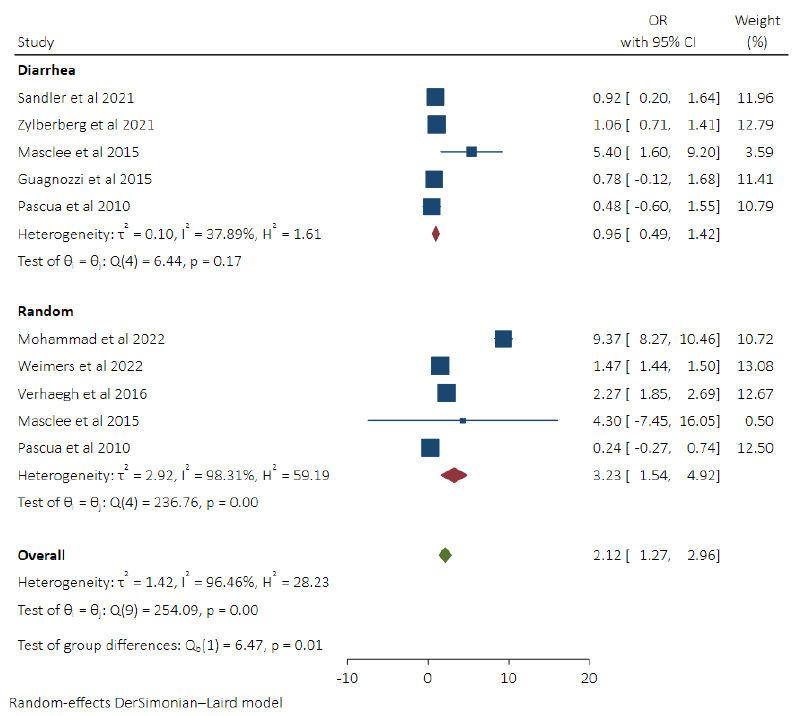
Figure 2. Pooled odds of MC in PPI users with subgroup analysis based on control groups (Diarrhea vs. Random Control) [8,9,12,13,17–19,21,22].